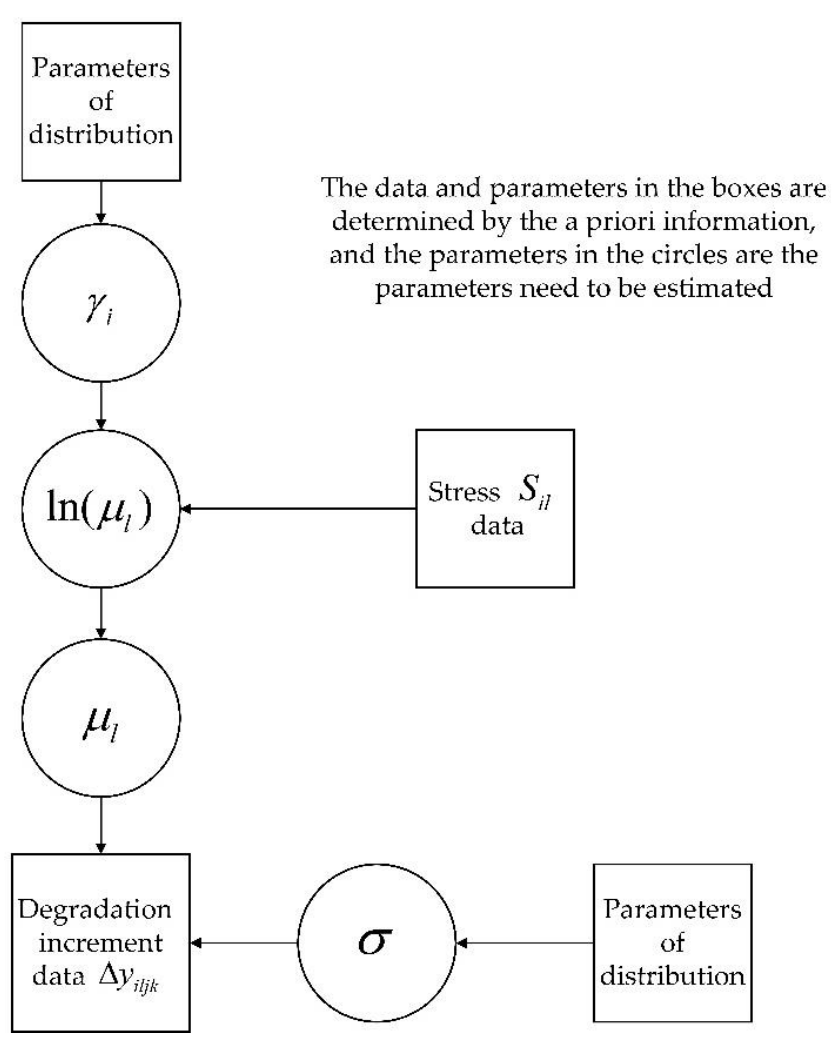
Figure 2. Relationship of model parameters. According to the parameter relations in Figure 2 and the expression form of the likelihood function (Equation (17), the parameter complex relations of the accelerated degradation model of the motorized spindle contain three layers, and the ordinary